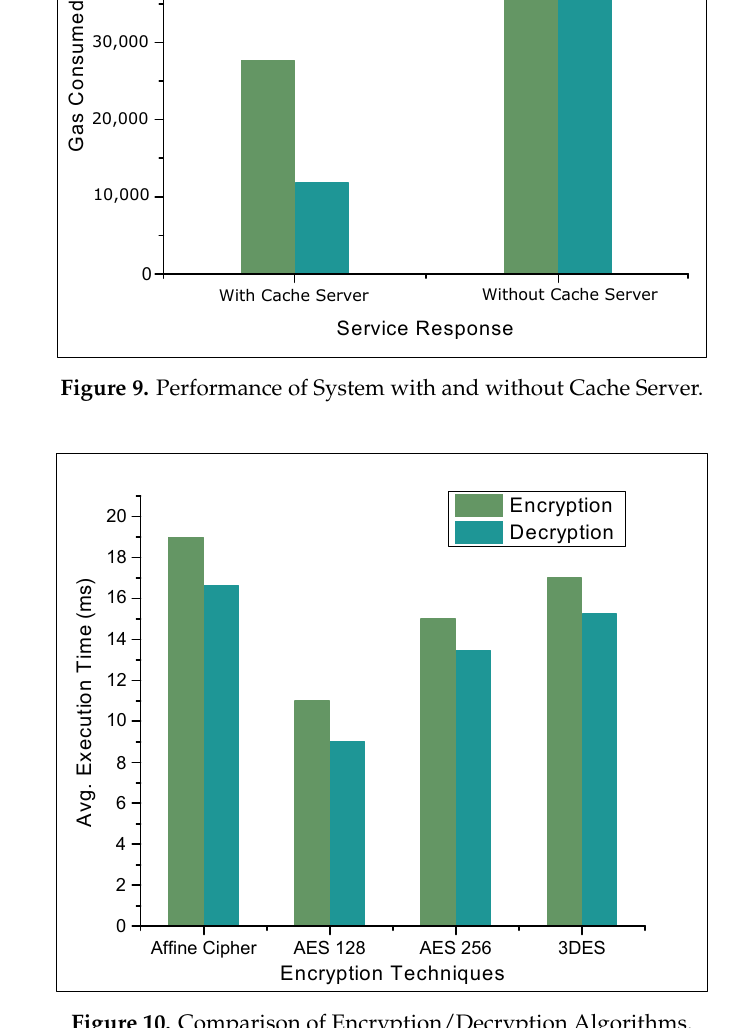
Figure 10. Comparison of Encryption/Decryption